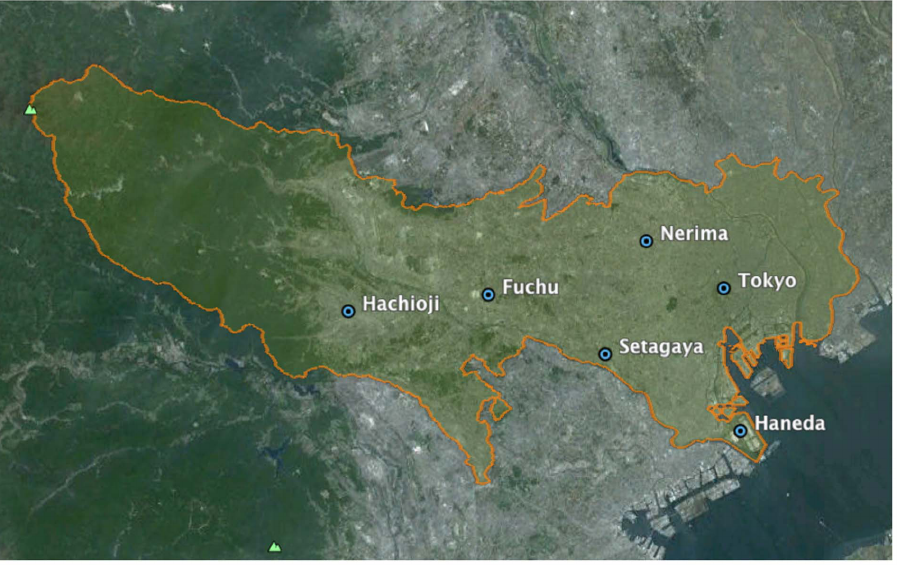
Figure 3. Locations of weather stations from which the data was gathered for the study. The area considered in this study is enclosed by highlighted contour line.